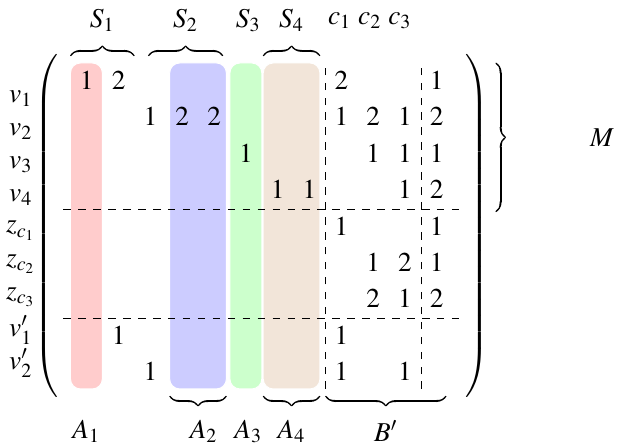
Figure 3: An example of a matrix M over F 3 , together with the vectors z c for c ∈ C = { c 1 , c 2 , c 3 } , and the vectors v (cid:48) for i ∈ I i